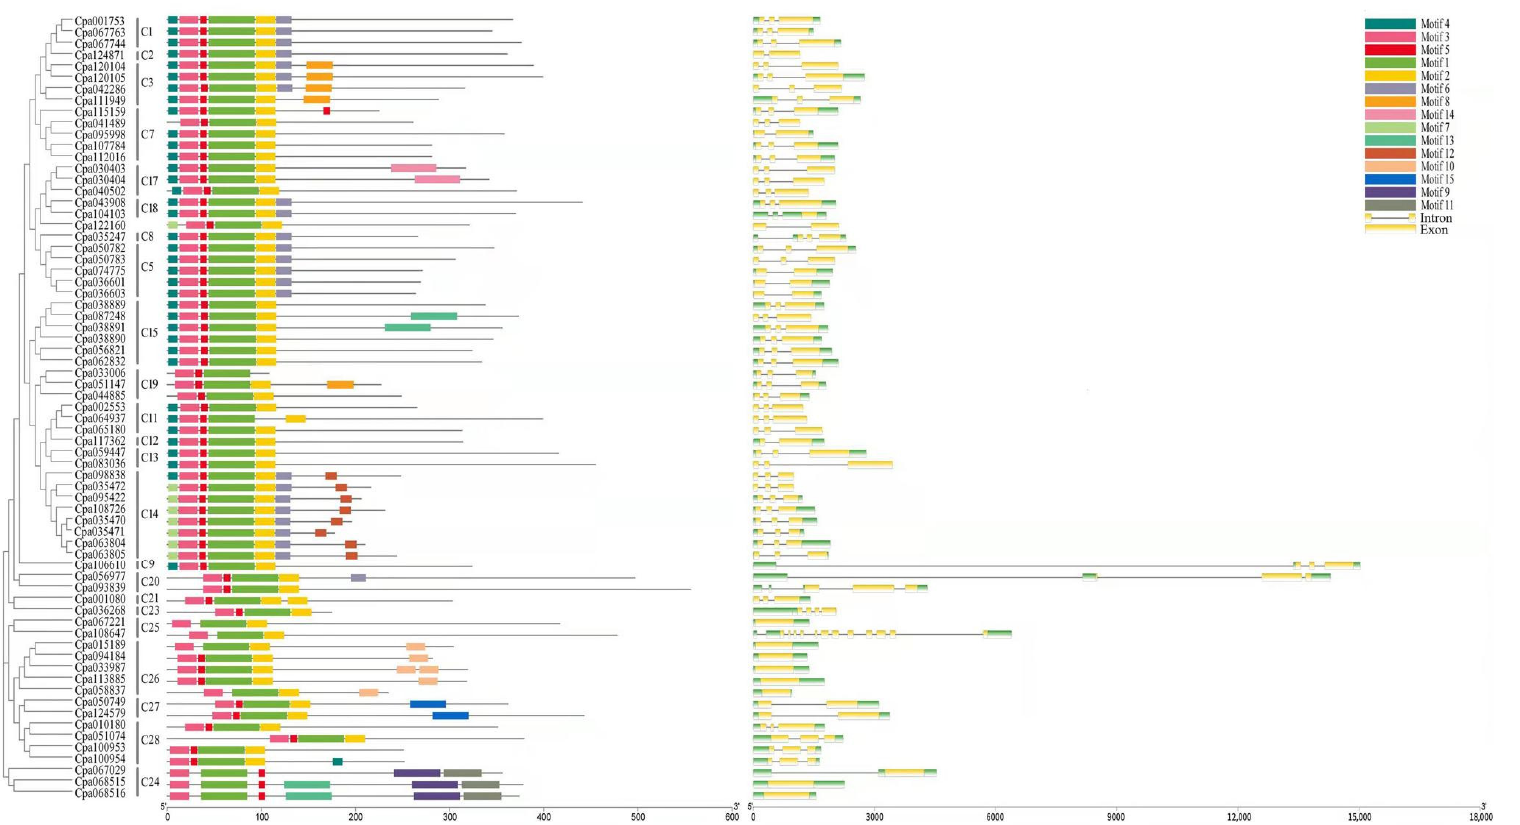
Figure 3. Phylogenetic relationship ( left ), motif distributions ( middle ), and exon/intron gene structures ( right ) of C. paliurus R2R3-MYB genes. Fifteen motifs were represented by fifteen kinds of colored blocks. The length of the gray line represents the length of a sequence relative to that of all the other sequences. The position of each block represents the location of the motif.